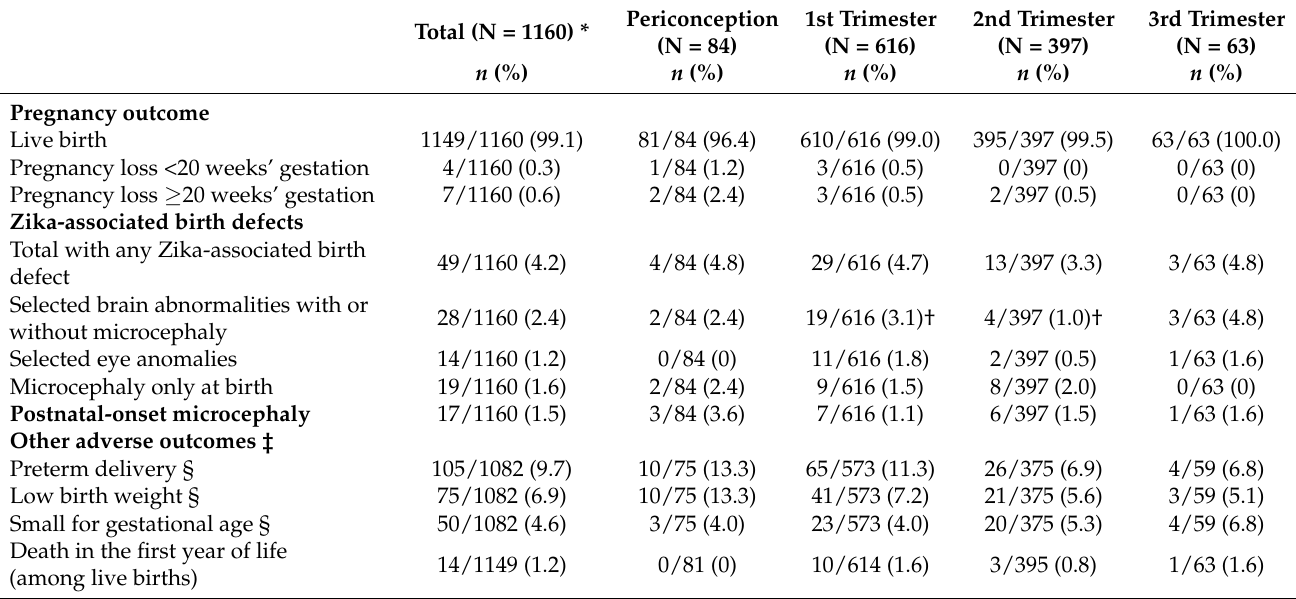
Table 3. Pregnancy and infant outcomes among pregnant women with symptoms of Zika virus disease, by trimester of symptom onset, Project Vigilancia de Embarazadas con Zika (VEZ), Colombia,